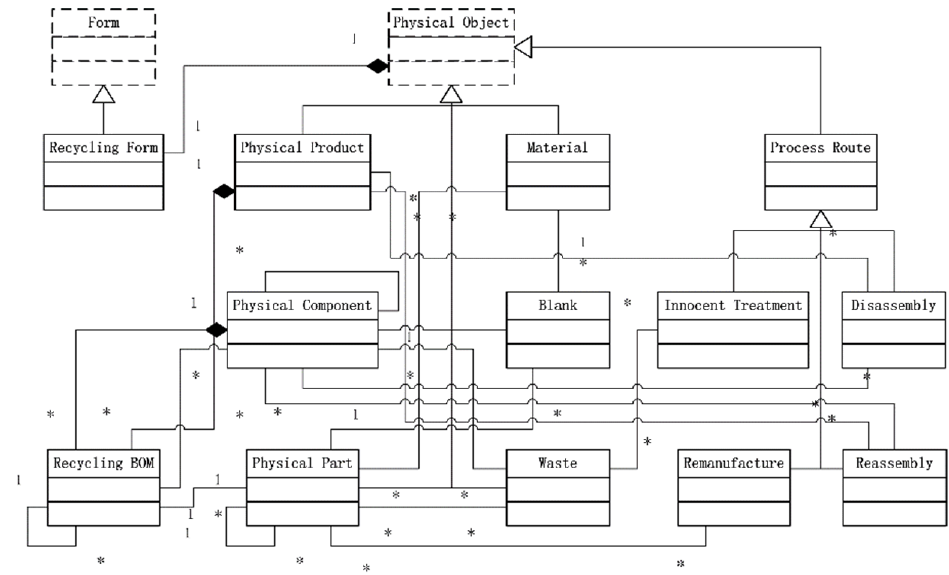
Figure 10. Recycling Private Data Model. (* represent the multi-object)